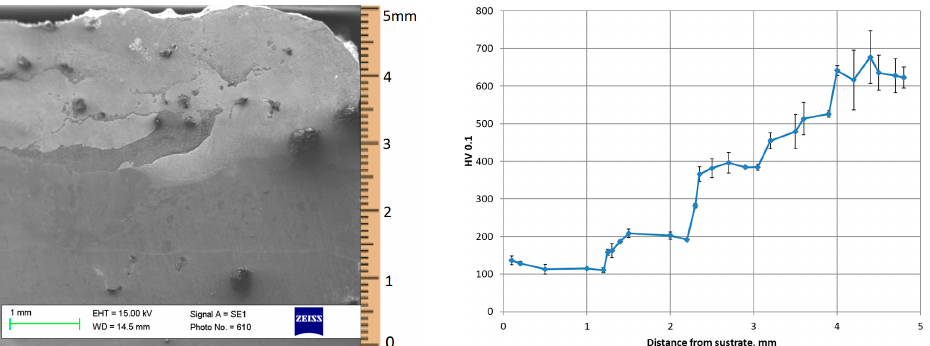
Figure 3. Optical micrographs and microhardness behavior of the DED of a Ti-Fe-graded layered sample produced by the 1st